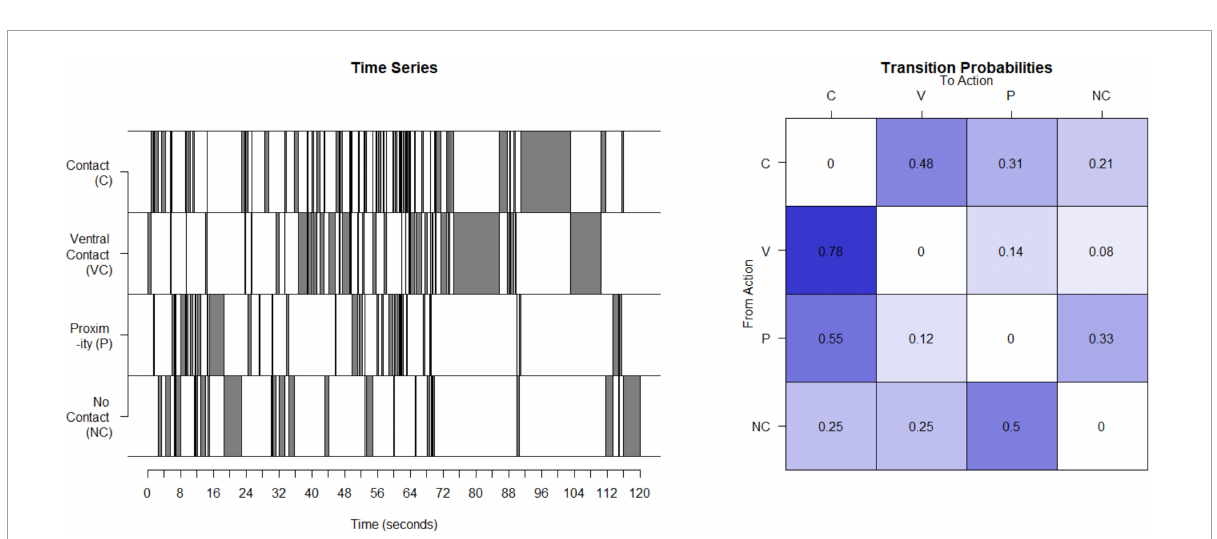
FIGURE2 Calculation of entropy rate in monkeys: This time series illustrates the four possible states for one example mother. This timeseries is then used to compute a transitional probability matrix. This matrix shows the percent of times a mother transitions from one state to